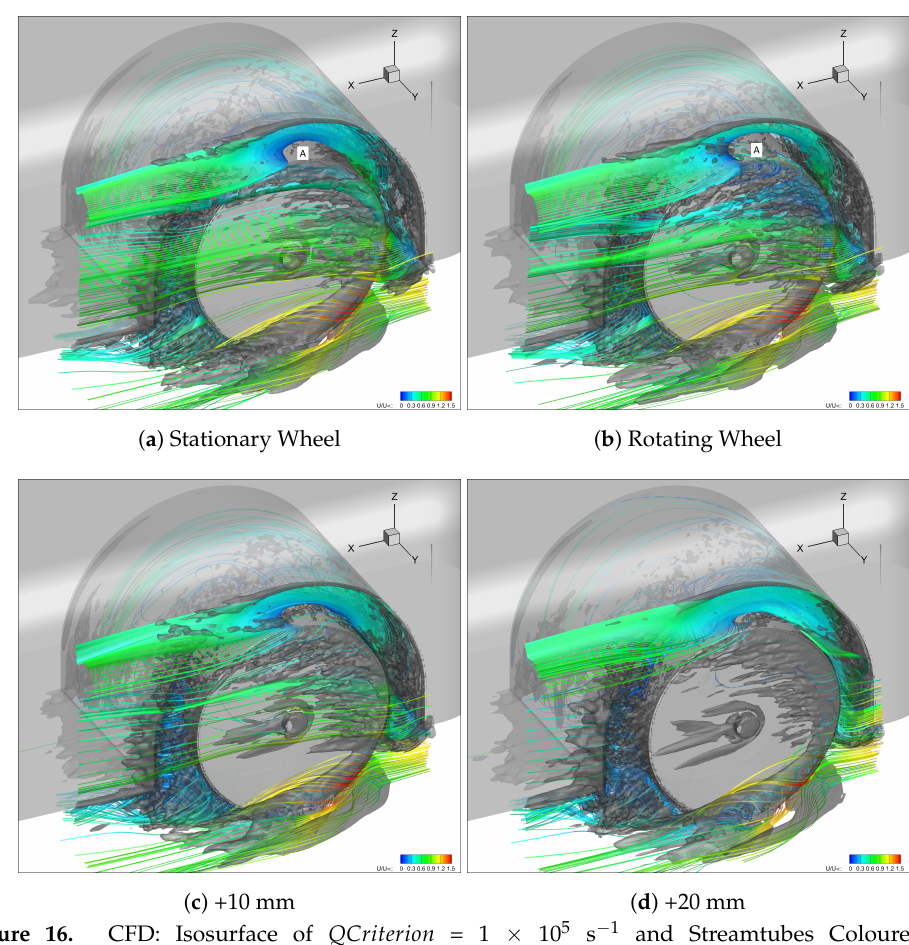
Figure 16. CFD: Isosurface of QCriterion = 1 × 10 5 s − 1 and Streamtubes Coloured by Velocity